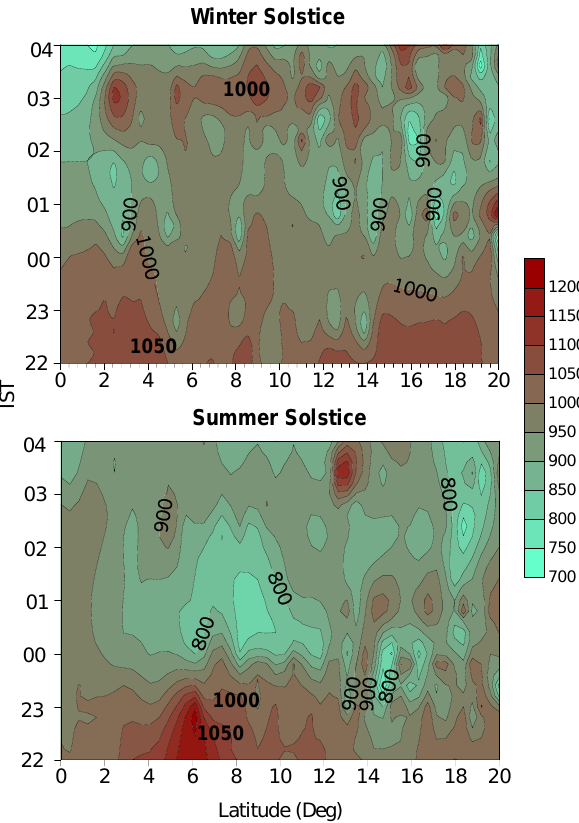
Fig. 5. Isothermal contours of electron temperature derived from the SROSS C2 RPA data for summer solstice months (bottom panel) and winter solstice months (top panel) during